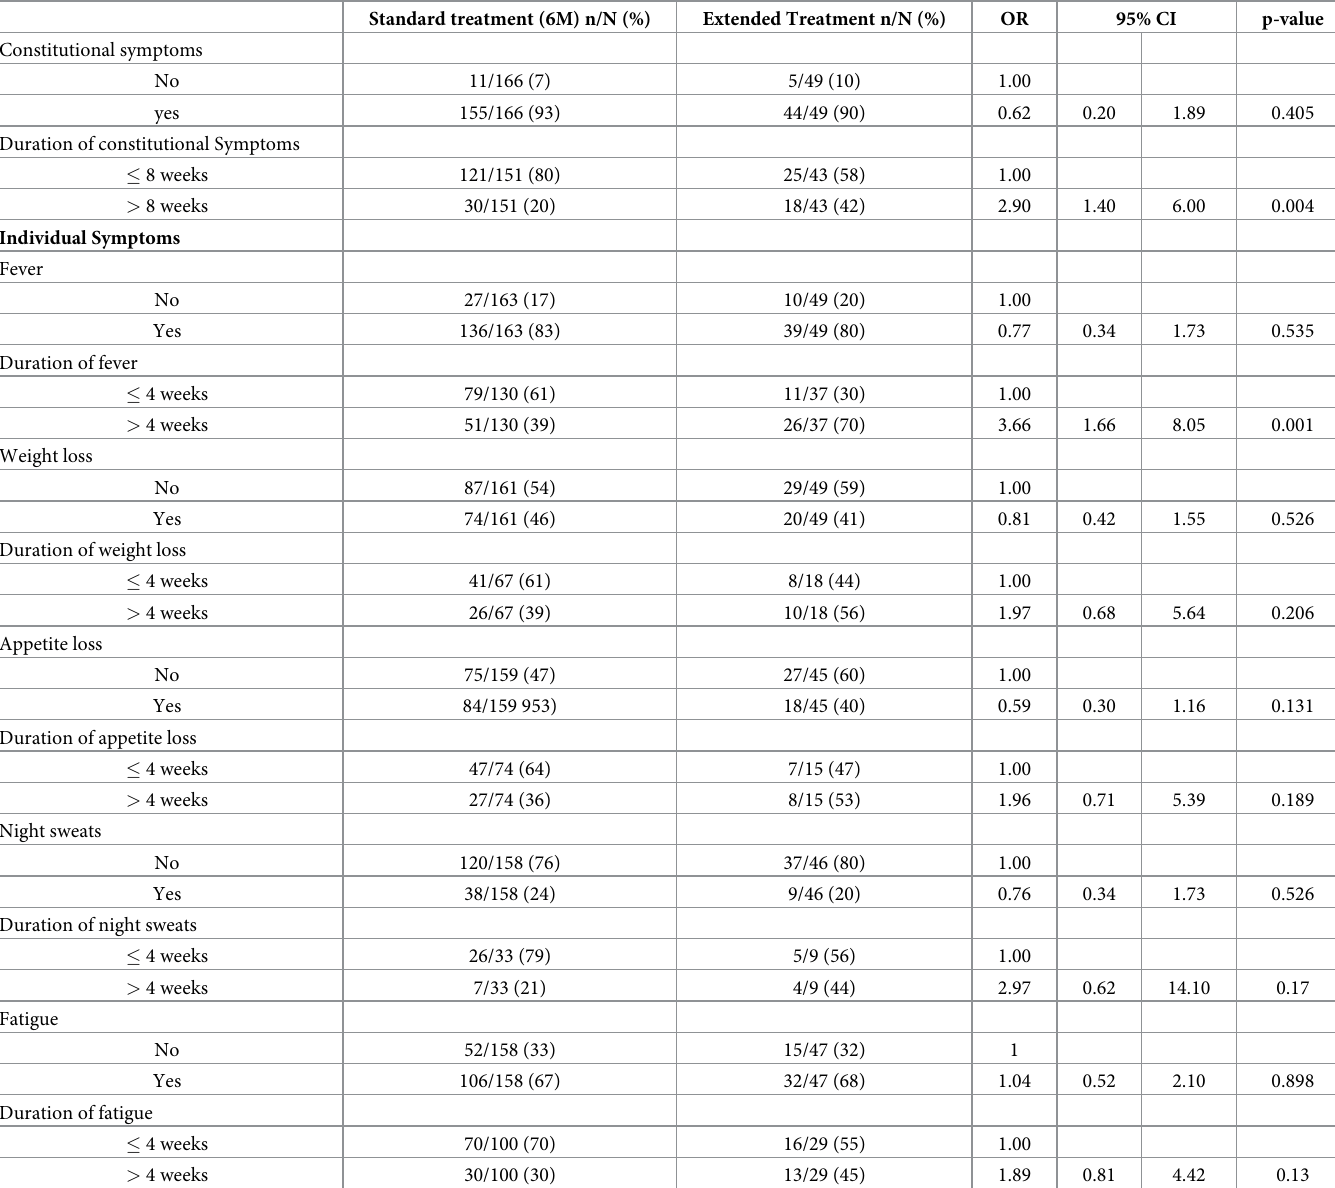
Table 2. Analysis of constitutional symptoms and duration of symptoms with prolonged treatment by univariable logistic regression model. Standard treatment (6M) n/N